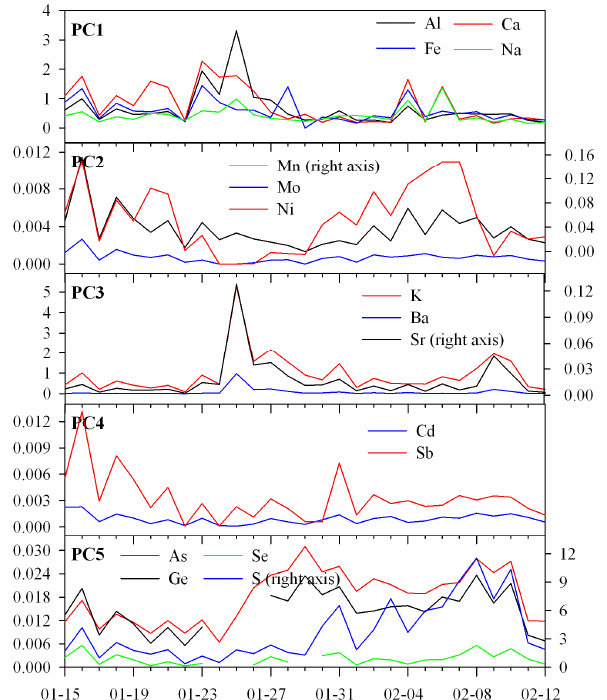
Fig. 5. Time series of daily OC, NO − Fig. 5. Time-series of daily OC, NO 3- , SO 42- , and NH 4+ concentrations ( μ gm -3 ) during the study period. tions (µgm − 3 ) during the study